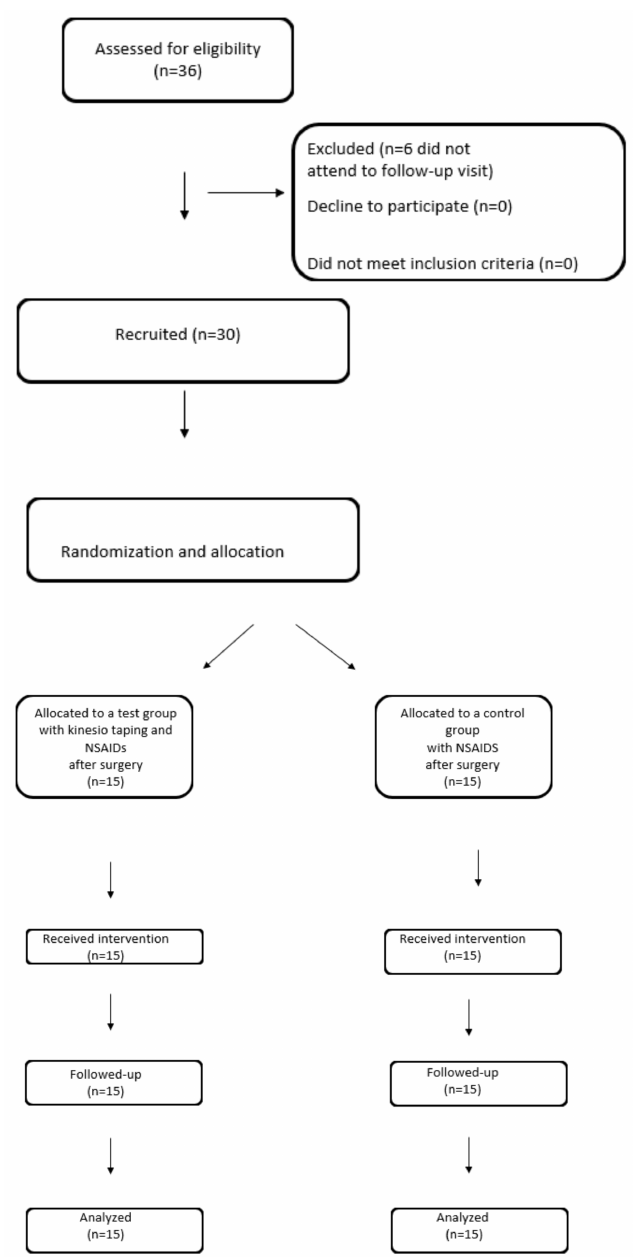
Figure 1. Flow chart of the study